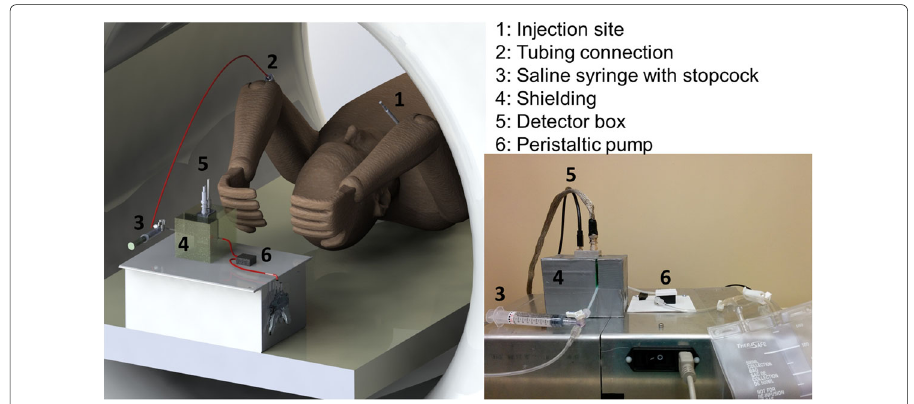
Fig. 8 Setup used to extract time-activity curves during clinical PET studies. ( Left ) 3D rendering and ( right )